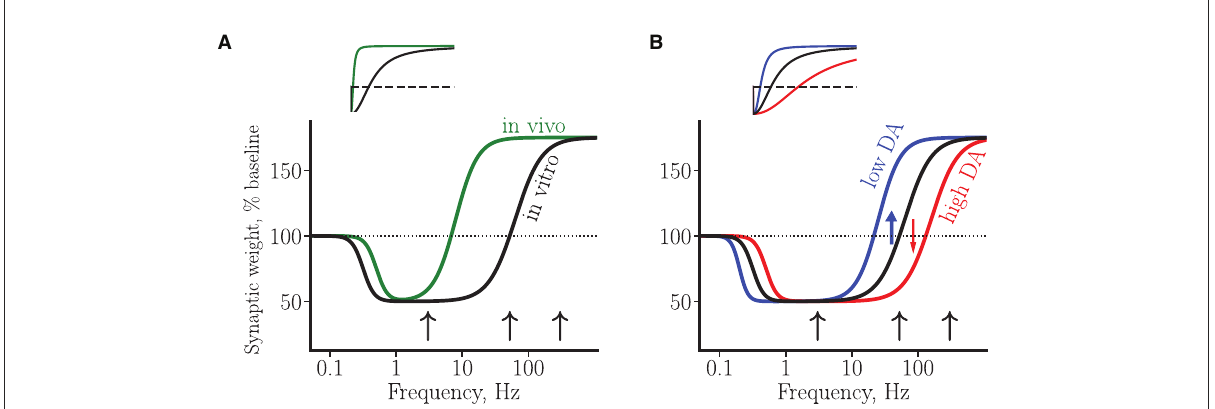
FIGURE2 A schematic summary of synaptic plasticity experiments using BCM curves. (A) Plasticity curves corresponding to in vivo (green line) vs. in vitro (black line) data. The LTD/LTP threshold in vivo has a lower value and the LTD window is narrower. (B) Plasticity curves corresponding to low (blue line) and high (red line) tonic DA concentrations, for the in vitro condition. The black curve in (B) is a copy of the curve in (A) . The blue and red arrows illustrate D1 facilitation of LTP and D2 facilitation of LTD by low and high DA concentration, respectively, near plasticity threshold. In both plots, the vertical axis corresponds to a change in average synaptic weight of a neuron, measured by the amplitude of somatic EPSP. The horizontal axis represents stimulation frequencies on a logarithmic scale. The black arrows correspond to a stimulation at low (3 Hz), intermediate (50 Hz) and high (300 Hz) frequencies. Insets: the same curves as in the main plots, shown on a linear